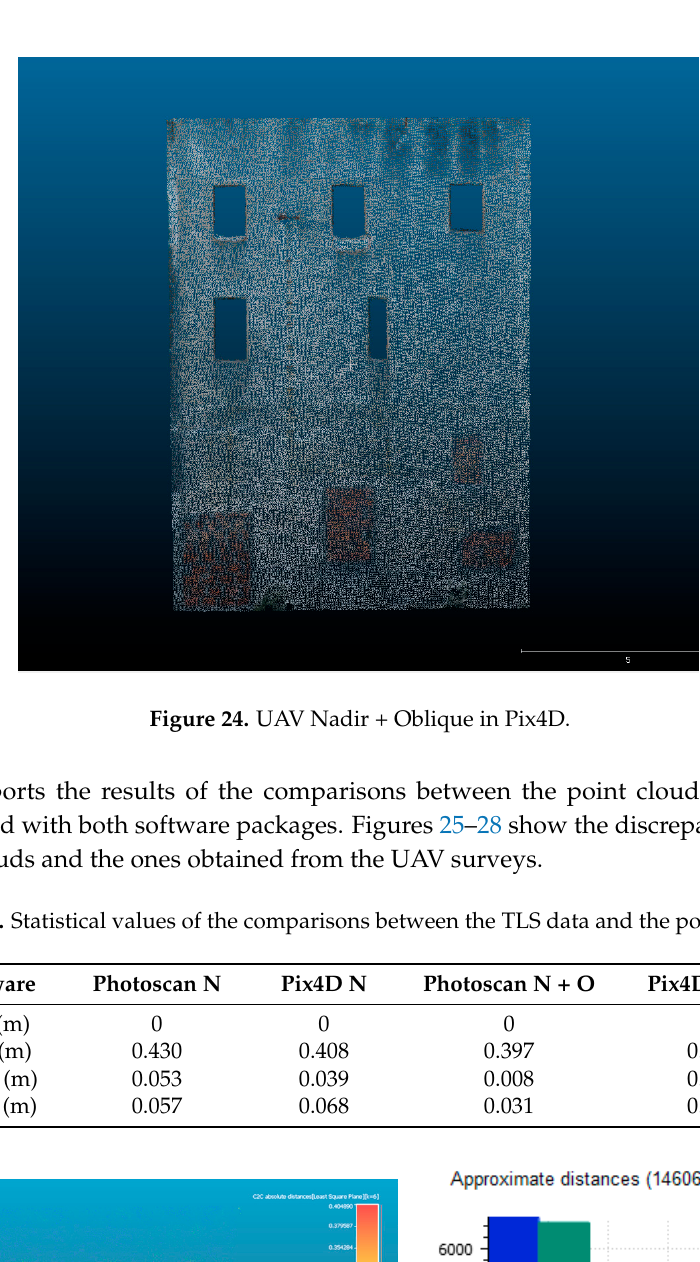
Figure 23. UAV Nadir in Pix4D.